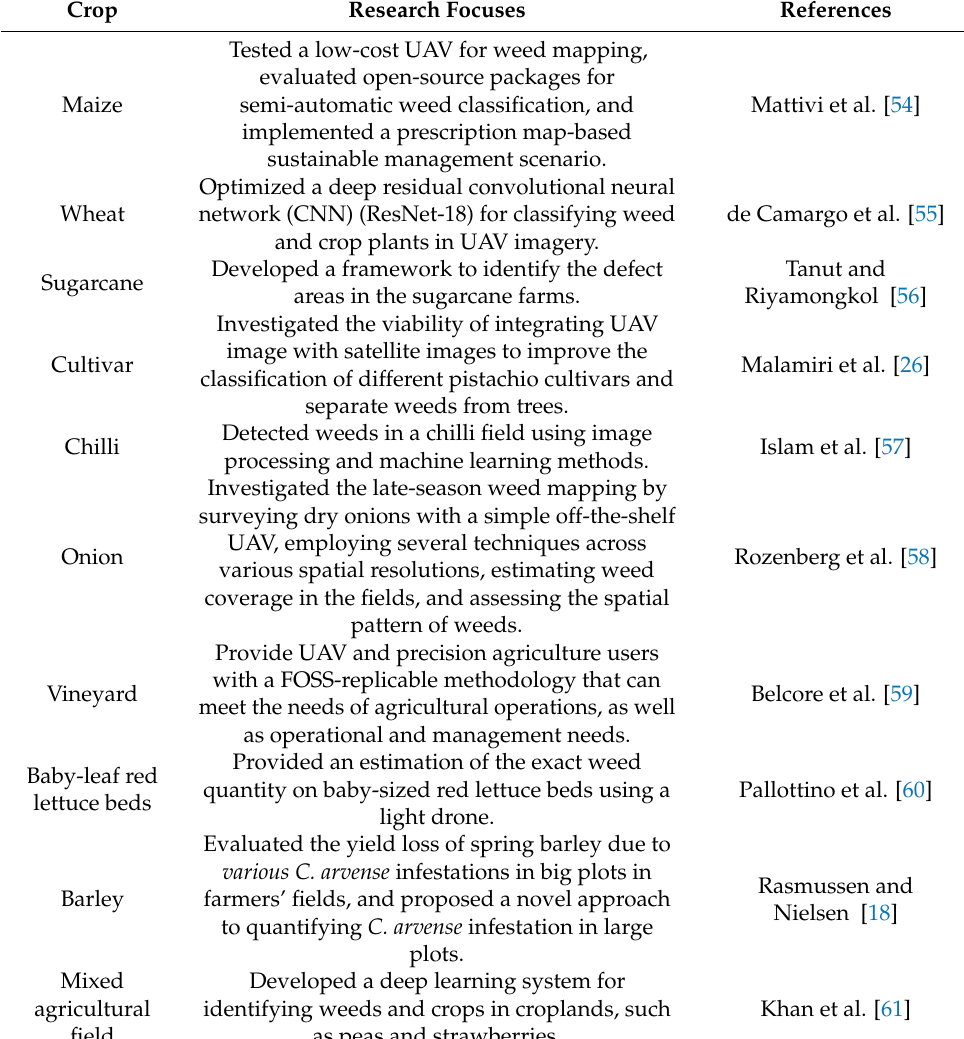
Table 6. Example of UAV imaging applications in detecting weed for different crop